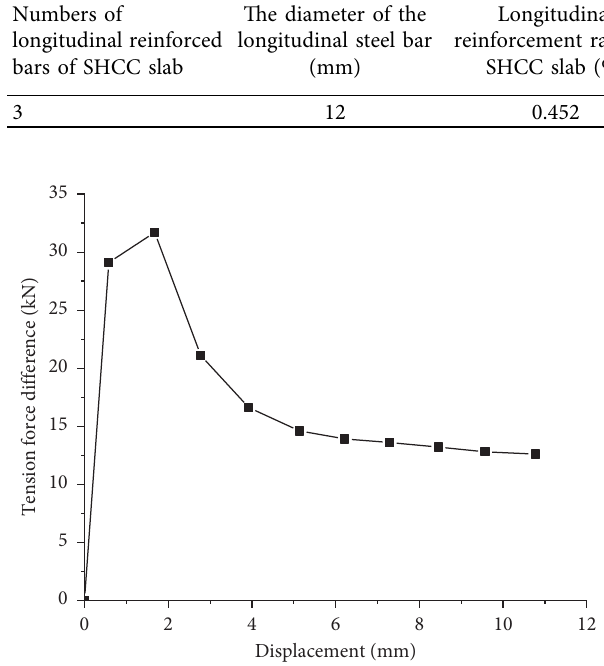
Figure 7: Relationship between tension difference and longitudinal displacement. Table 4: Measured coefficients between SHCC slab and concrete